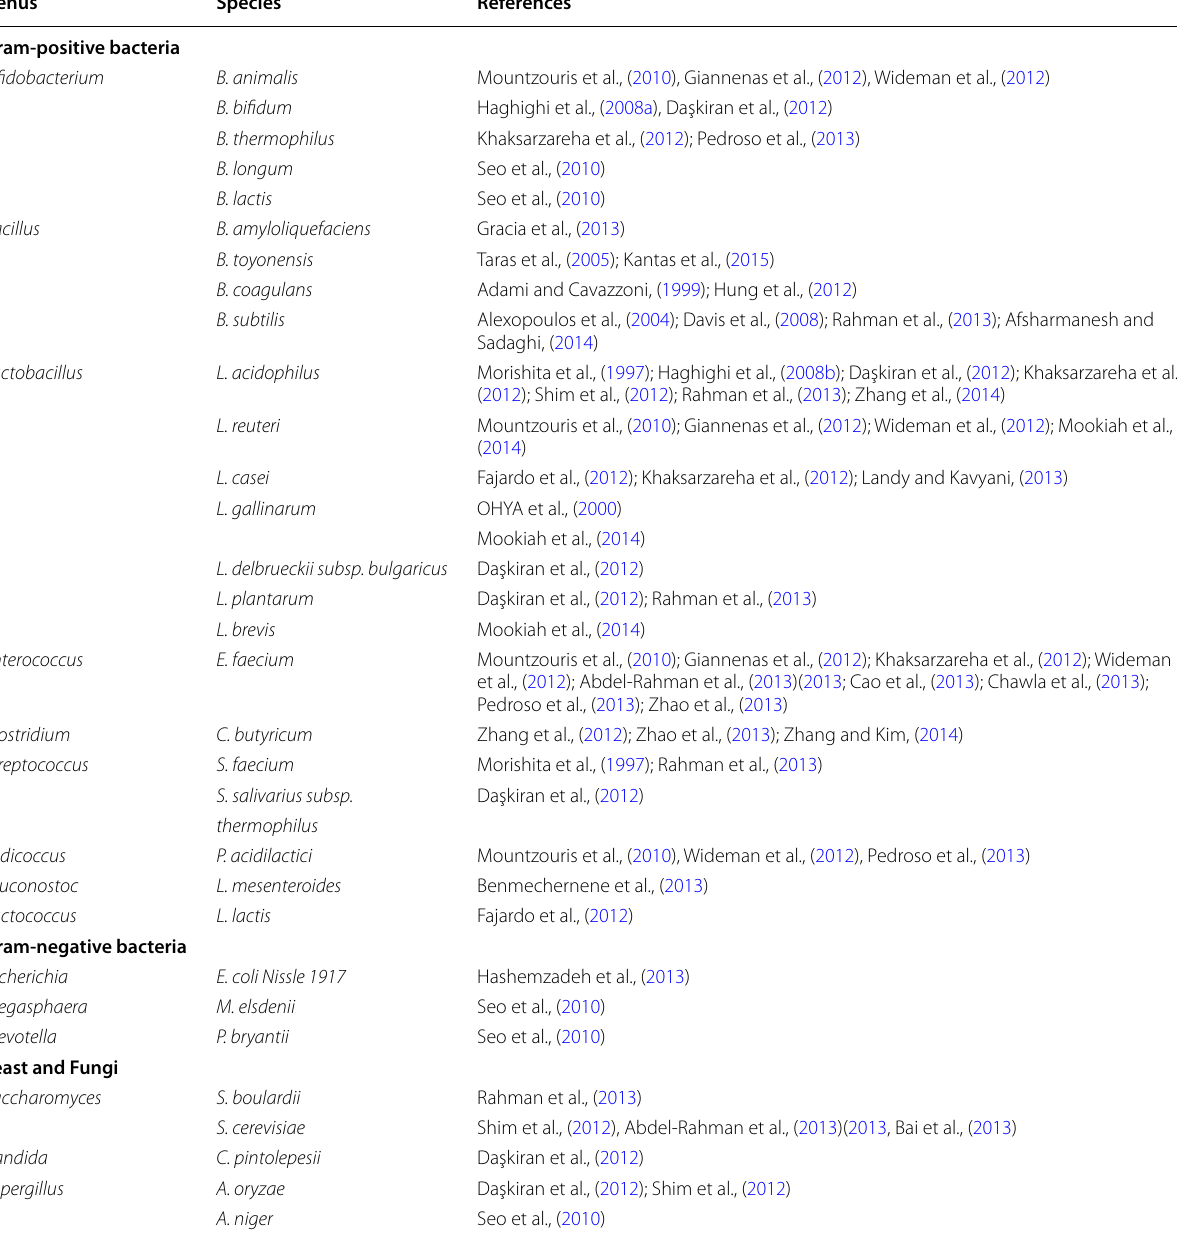
Table 1 A diverse range of microorganisms commonly used as probiotics in animal Genus